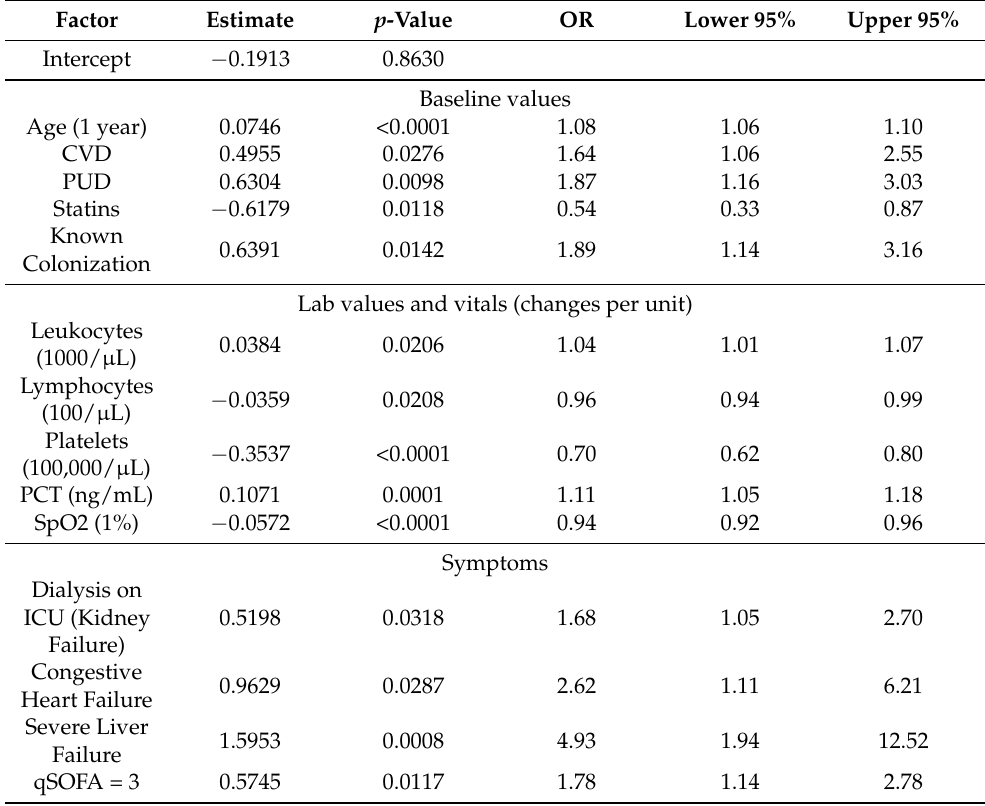
Table 3. Results of the multifactorial logistic regression for the binary response survival (dead versus recovered). The bootstrap validation of the model yielded an AUROC of 0.88 (95% CI: 0.86; 0.91). The columns show the parameter estimate, the p -value, and the odds ratio (OR) with its 95% confidence level. For continuous variables, the unit is indicated. For all other variables, the odds ratio refers to the occurrence of the specified event versus